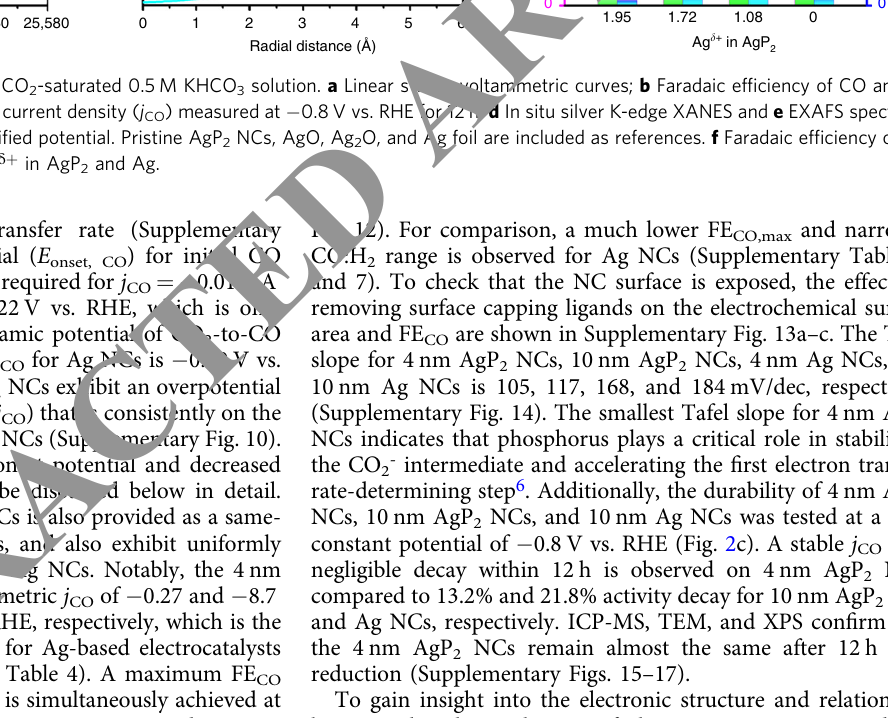
NATURE COMMUNICATIONS| (2019) 10:5724